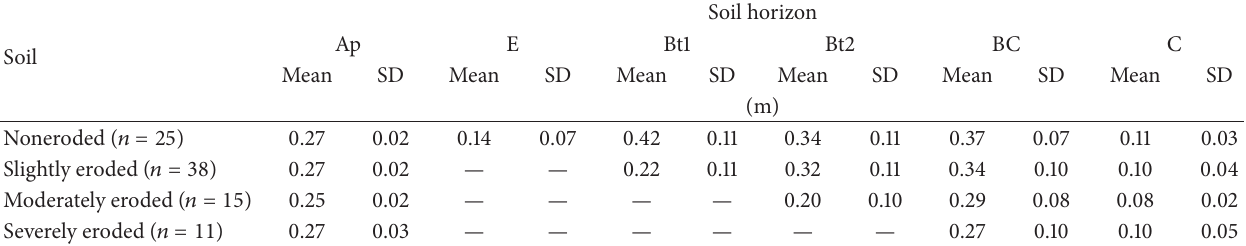
Table 1: Mean depth and standard deviation (SD) of soil horizons of noneroded and eroded soils.